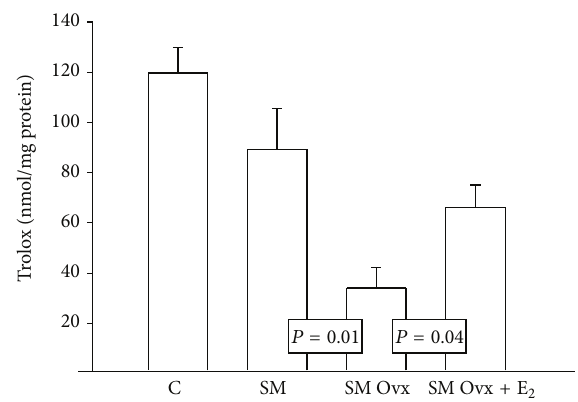
Figure6:Effectsoftheovariectomyandestradiolreplacementupon the antioxidant capacity of the nonenzymatic system. See Table 1 legend for abbreviations. Values are means ± SE; 𝑛 = 8 each